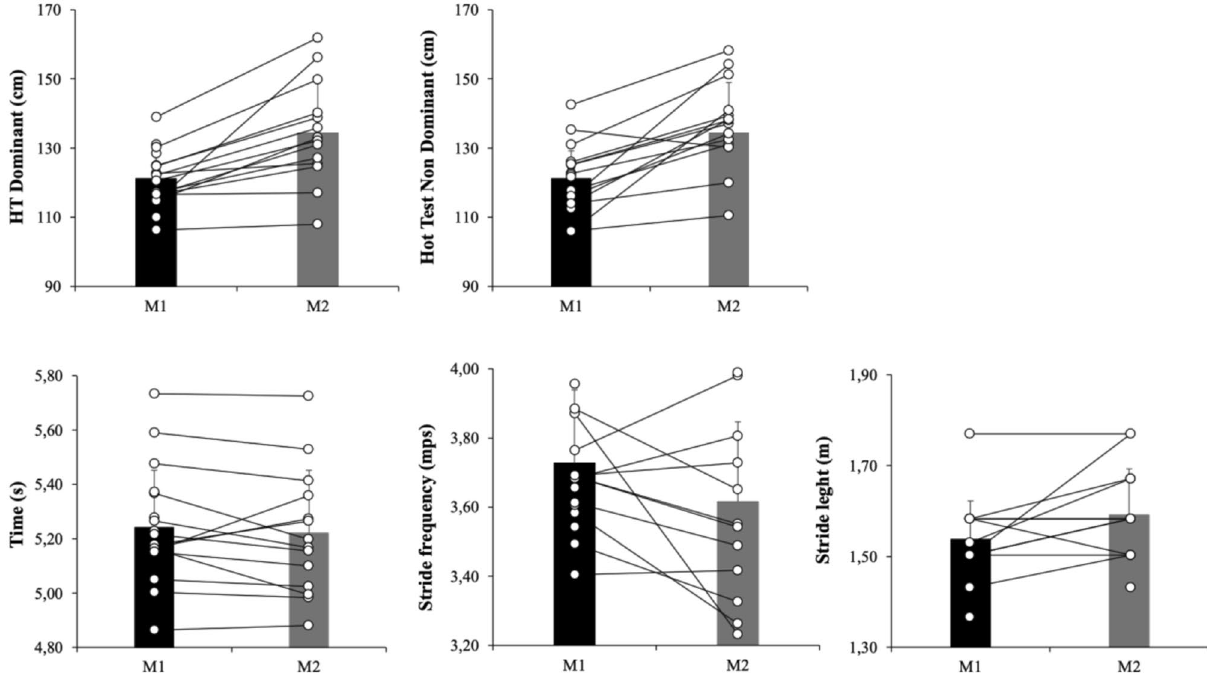
Figure 3. Performance variables (Hop test and Linear Sprinting 30-m) in moment 1 (M1) and Moment 2 (M2).